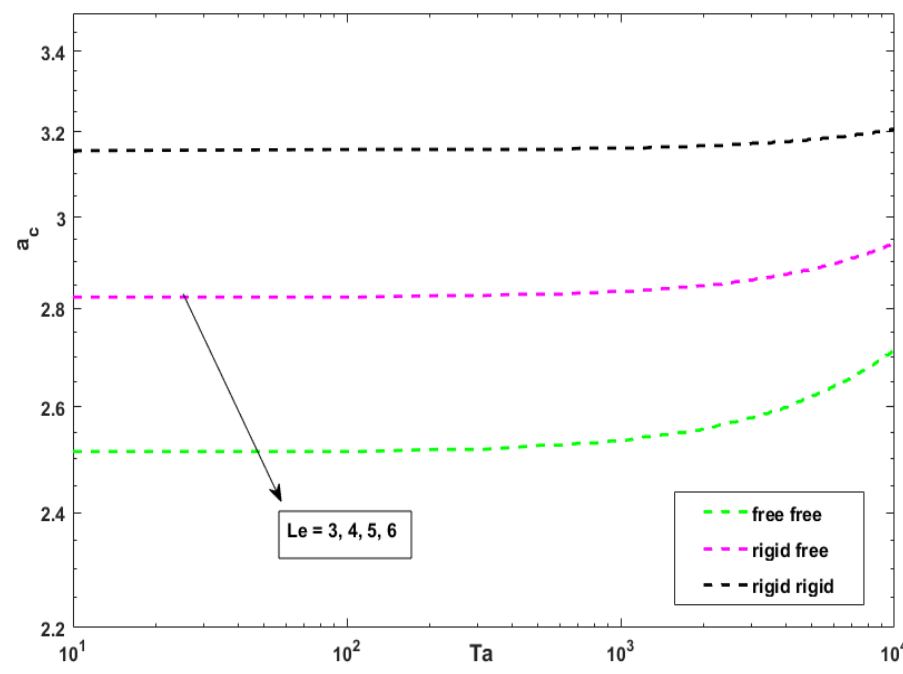
Figure 9. Variation of a c with Ta for Da = 0.01, Du = 0.02, Rs = 200, Sr = 0.2, Λ = 8, M = 0.9, φ = 0.9.